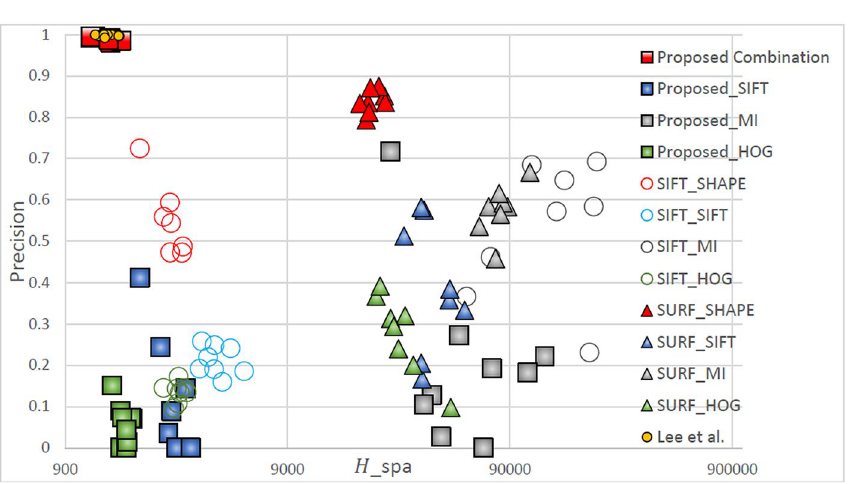
Figure 6. Quantitative comparison of matching in TYPE II through different matching combinations.